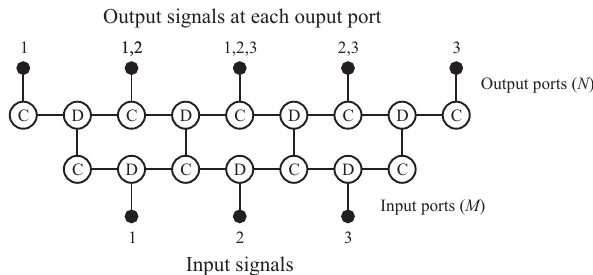
Figure 2. Typical coherent beamforming network (C-BFN) topology based on unit cells for power division/combination, illustrating the shared aperture at the